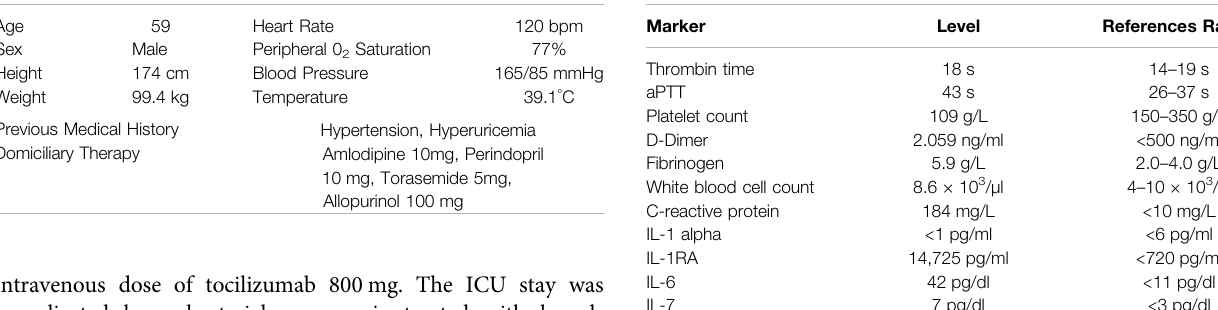
TABLE 1 | Patient ’ s clinical data on admission. TABLE 2 | Coagulation and in fl ammatory markers on